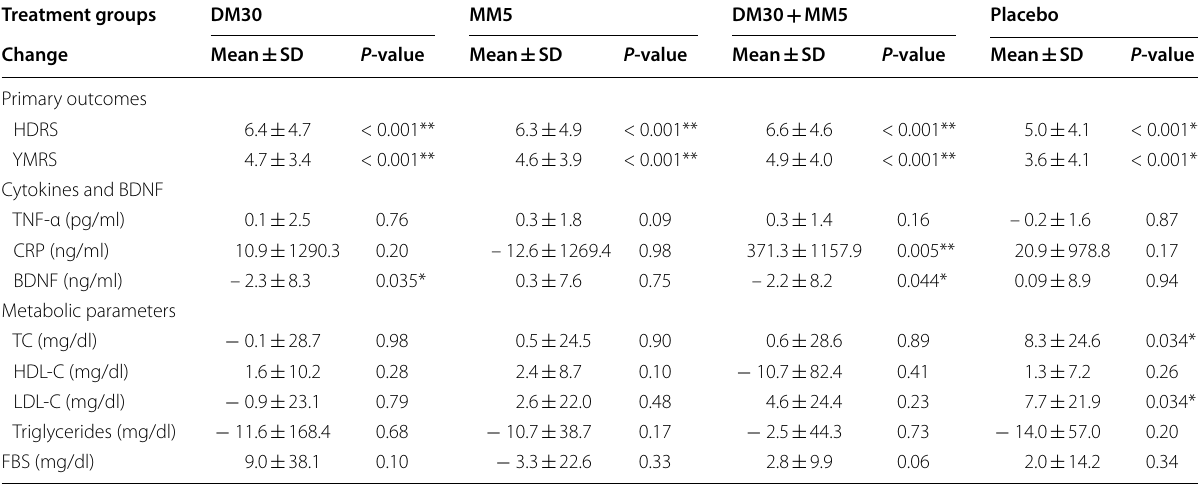
The difference between baseline and endpoint after 12 weeks of follow-up analyzed using a paired sample t